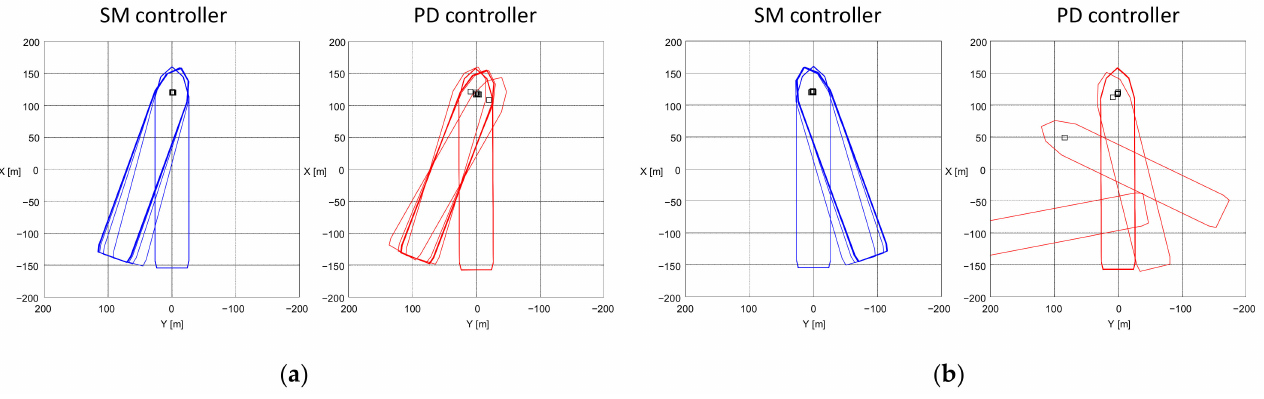
Figure 16. Trajectories of a vessel with dynamic positioning systems with environmental disturbance in comparison of sliding mode (SM) and proportional-integral (PD) controllers: ( a ) case 1 and ( b ) case 2.